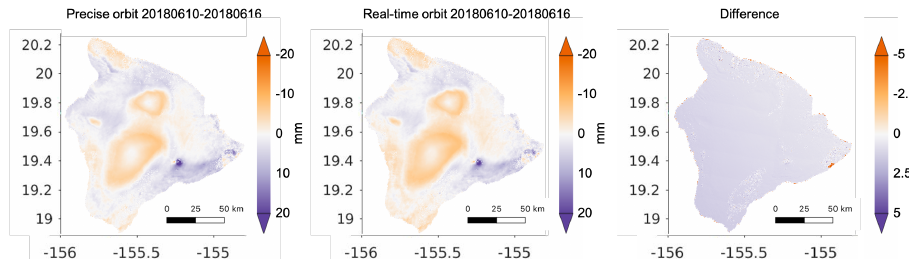
Figure 6. Interferograms computed between 10 June 2018 and 16 June 2018 using real-time ( left ) and precise ( middle ) orbits. The ( right ) panel shows the difference, note the change of scale. On this plot, we show the unwrapped phase where high (purple) values represent an LOS increase in distance from the satellite, which means subsidence on the ground. Consequently, low (orange) values mark a decrease in the LOS distance, which means uplift on the ground.